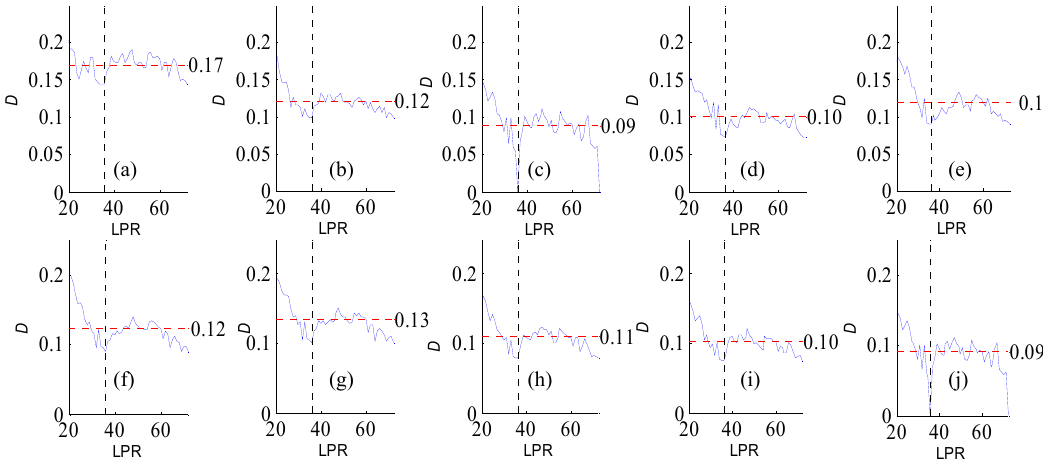
Figure A23. Variation of flow regime alteration degree (D) measured by the RVA with change in the length of pre-impact flow time series (LPR) under the periodicity of 36 years. ( a ), ( b ), ( c ), ( d ), ( e ), ( f ), ( g ), ( h ), ( i ), and ( j ) correspond to pre-impact flow time series length = 26, 31, 36, 41, 46, 51, 57, 62, 67, and 72 years, respectively. The abscissa value for the vertical dotted line is 36. The ordinate value for the horizontal dotted line is the mean degree of flow regime alteration in each subfigure. Water 2020 , 12 , x FOR PEER REVIEW